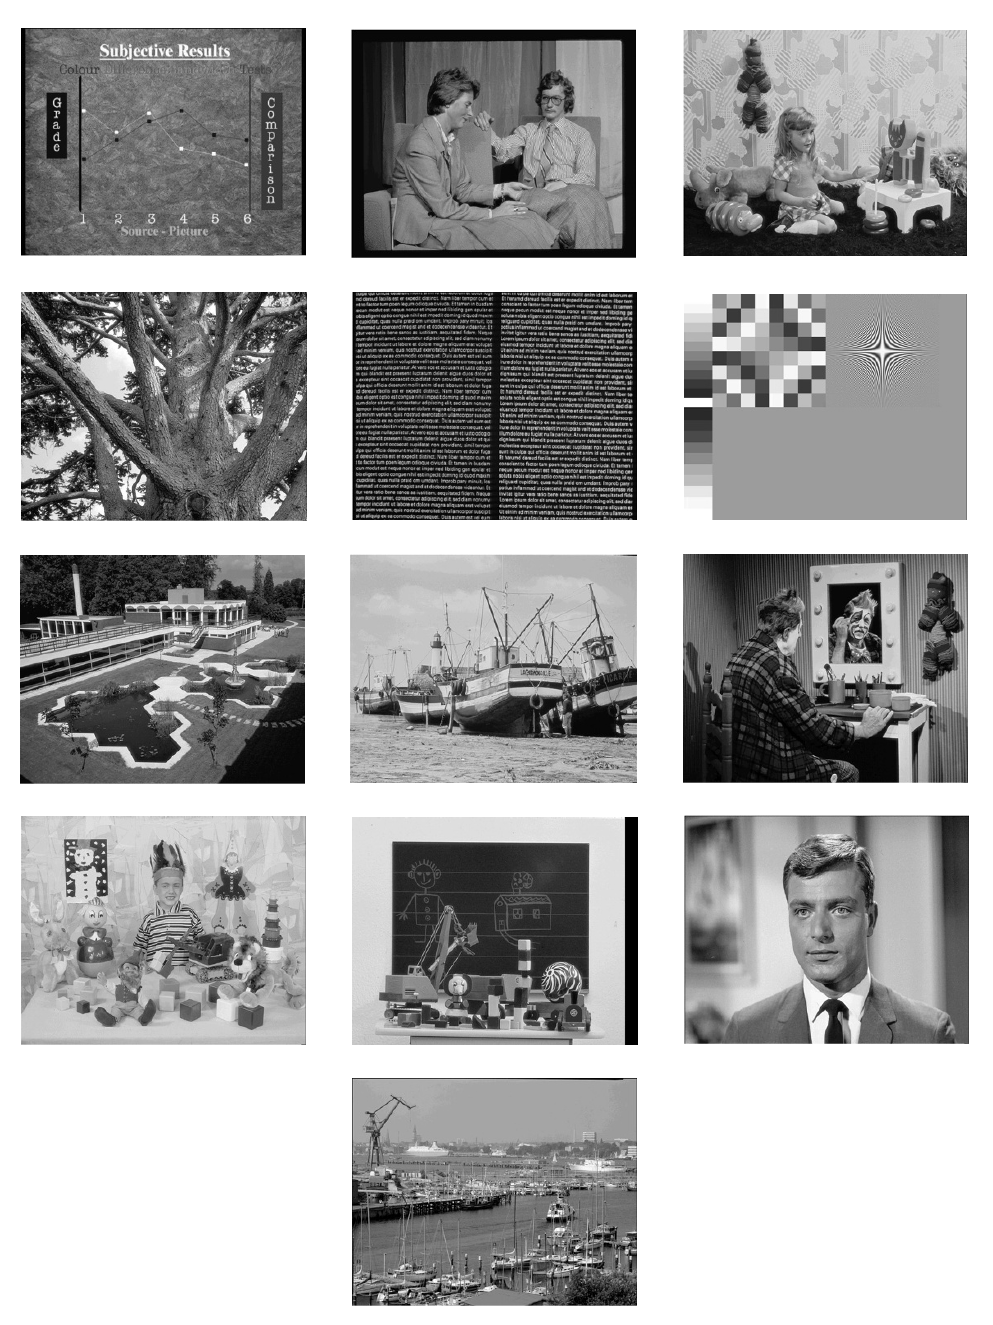
Figure 1: Images used for